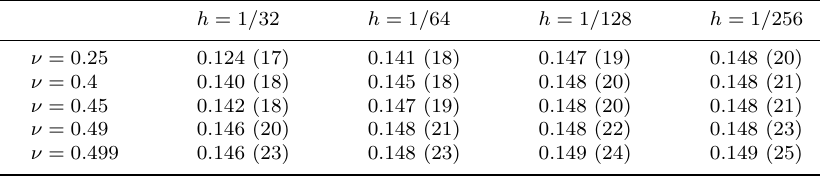
Table 4. Multigrid convergence. Variation of the properties of the elastic solid. h = 1 / 32 h = 1 / 64 h = 1 / 128 h = 1 / 256 ν = 0 . 25